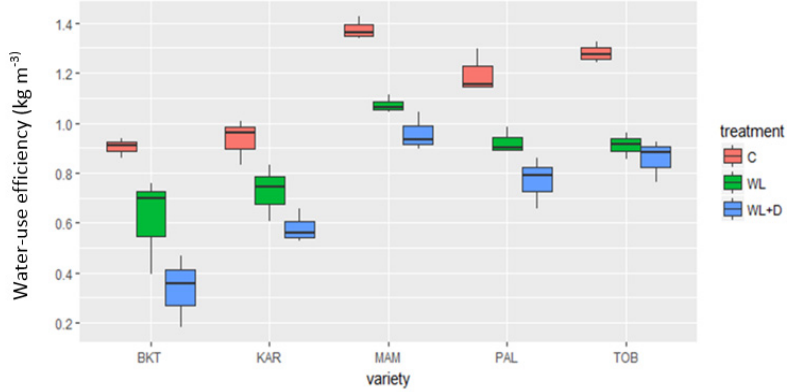
Figure 6. Water-use efficiency of ‘Bánkúti 1201’ (BKT), ‘Mv Toborzó’ (TOB), ‘Mv Mambó’ (MAM), ‘Mv Karizma’ (KAR) and ‘Mv Pálma’ (PAL) varieties in the different treatments. ‘C’: control treatment; ‘WL’: waterlogging treatment; ‘WL + D’: combined treatment of waterlogging and drought (n = 3).